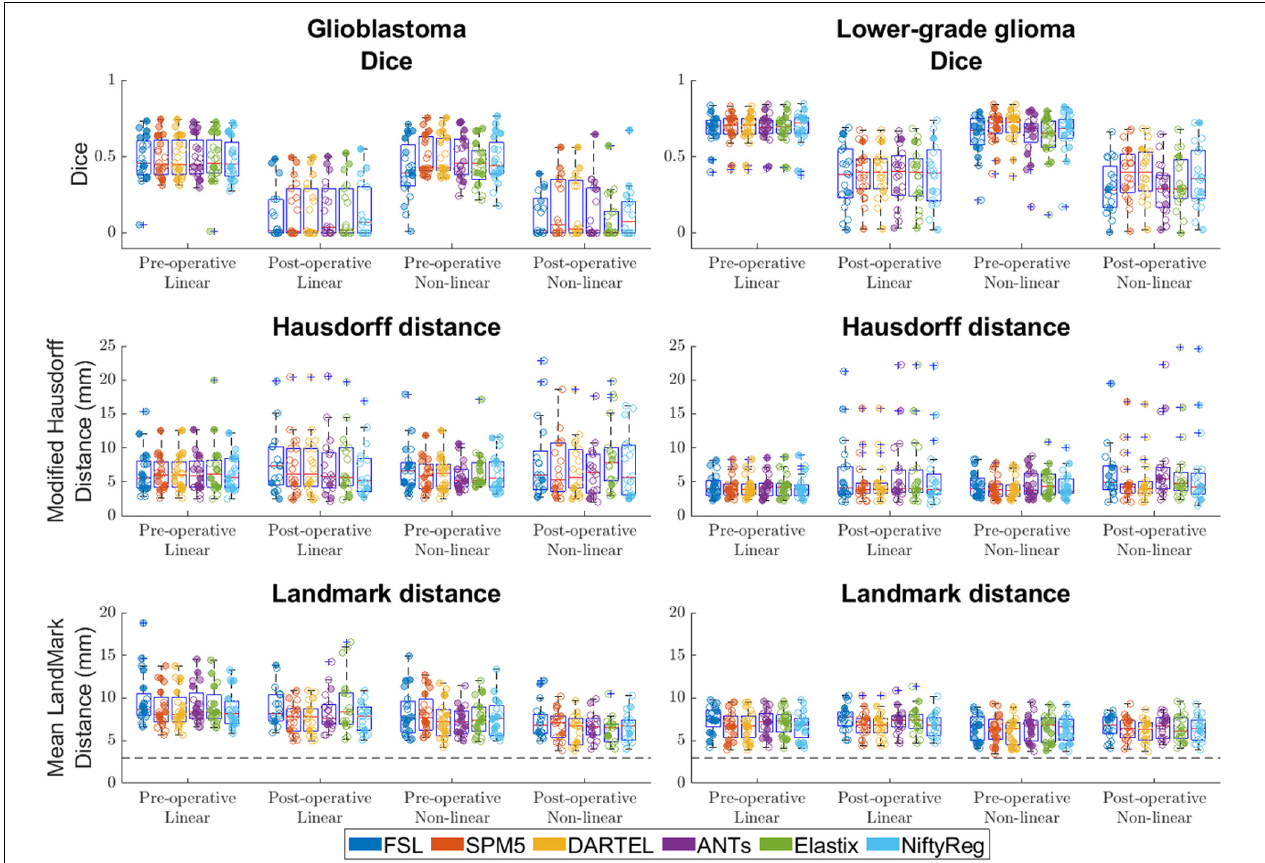
FIGURE 5 | Accuracy of the six packages for both linear and non-linear registration of the pre- and post-operative time-points. Left column shows accuracy for glioblastoma, and the right column for lower-grade glioma. For Dice score higher values indicate better accuracy, for Hausdorff and mean landmark distances smaller values indicate better accuracy. The dashed line indicates the average intra-rater agreement as reported previously (Chollet et al., 2014), multiplied by two to account for error in placement in both patient and ICBM2009a space. Each dot is a data point for an accuracy measure for a single patient. Dot transparency is controlled by the volume of the tumor connected to that data point divided by the maximum tumor volume in that distribution (more transparent is smaller relative volume). The whiskers extend to the most extreme data points not considered outliers, outliers are plotted individually using the ‘+’ symbol, boxes show the interquartile range, and the contained red line shows the median of each respective